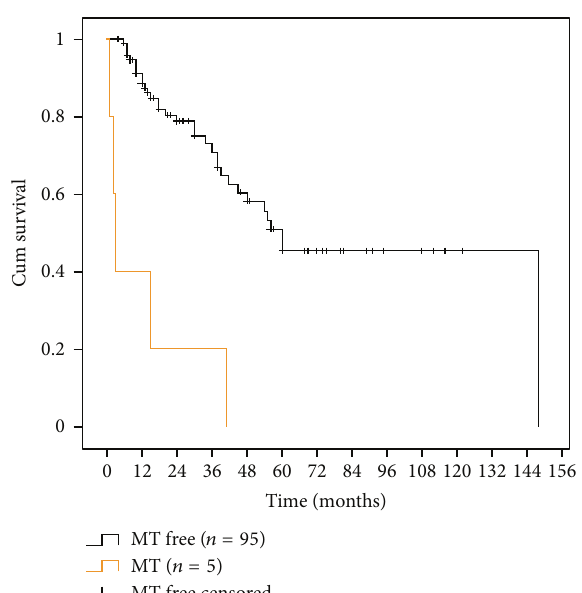
Figure 6: Kaplan-Meier analysis plotting disease-free survival for (same site) malignant transformation and malignant transfor- mation-free patients ( 𝑃 = 0.0001 , Log-Rank